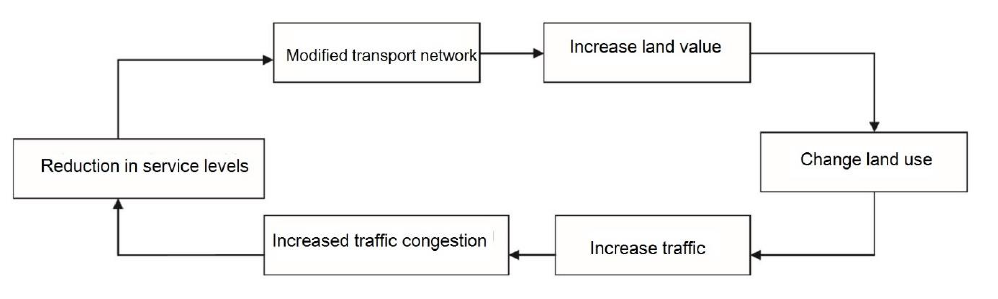
Fig. 1. The relationship between land use and transportation [30].